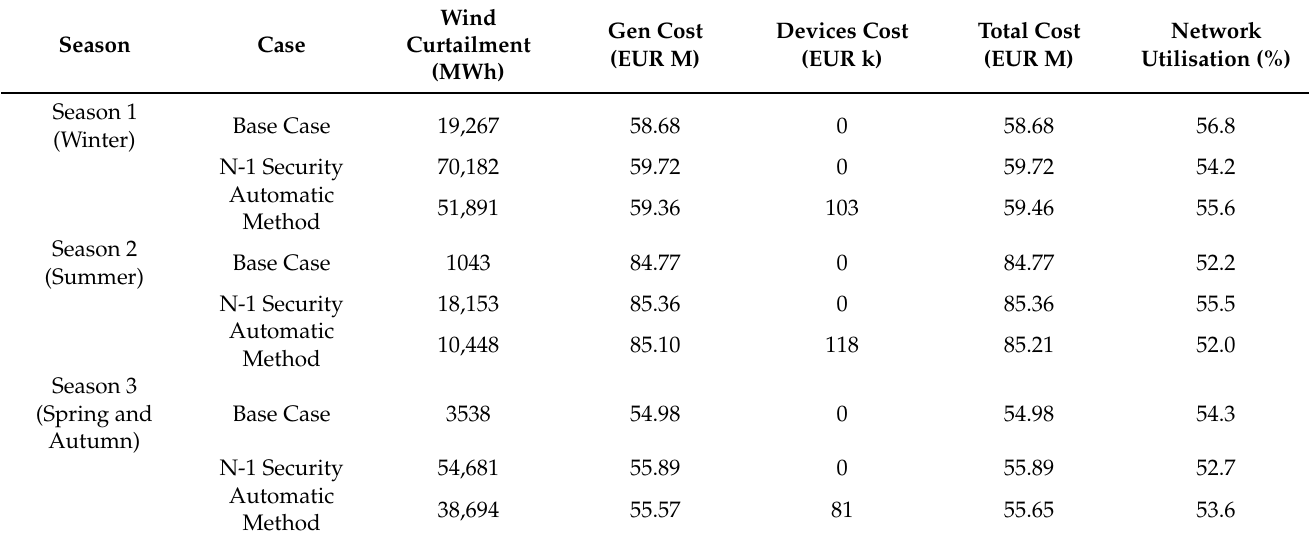
Table 2. Mobile MSSSC allocation simulation results.